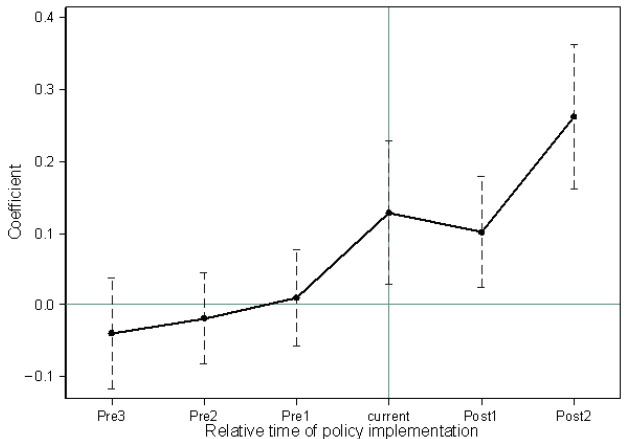
Figure 2. Parallel trend test results. Note: Regression coefficients in the figure have been expressed as relative values to the base period and clustered to the citylevel standard errors.